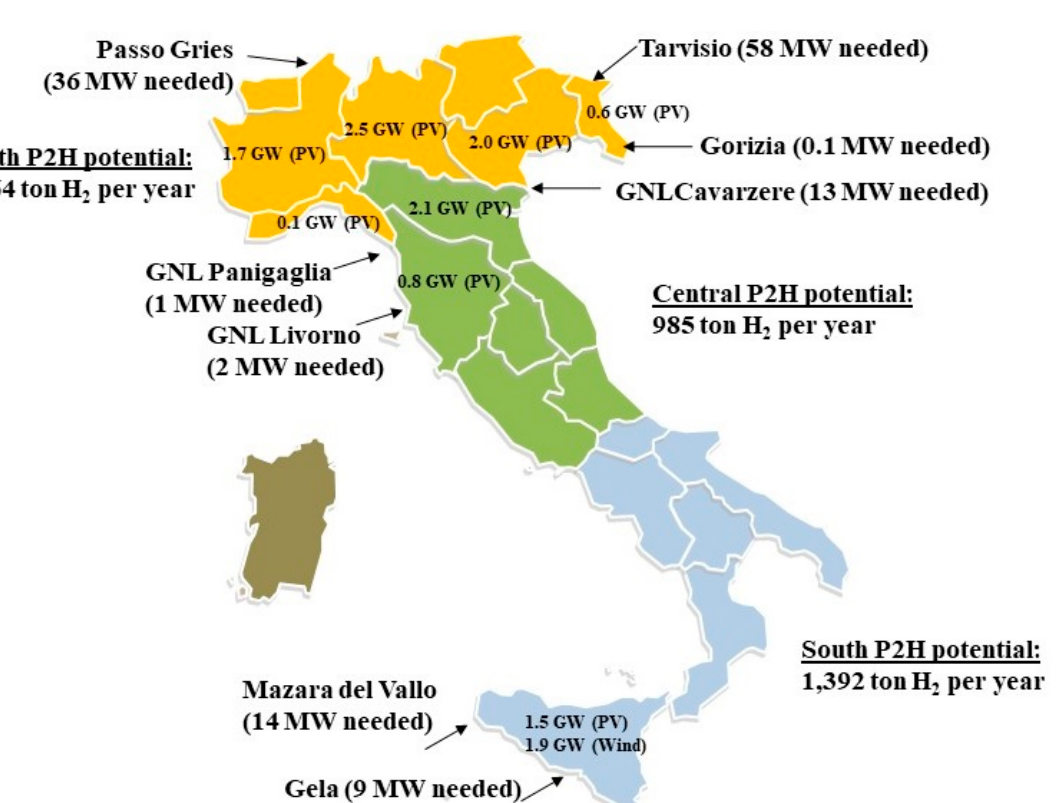
Figure 6. Location and size of the P2H plants in Italy and relation with regional renewable power availability.